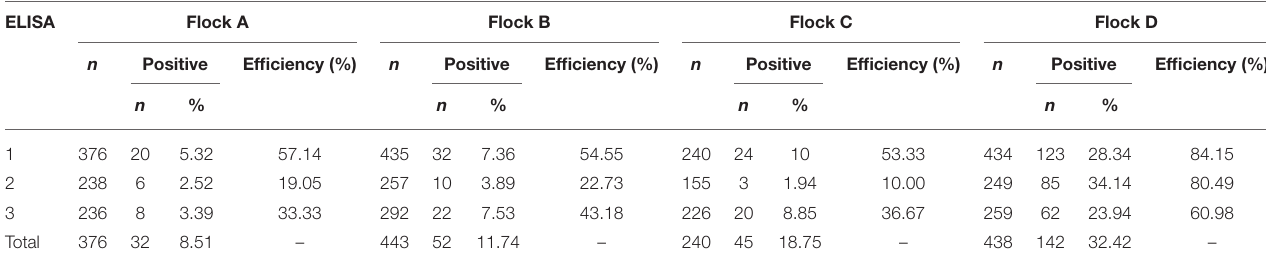
TABLE 2 | SRLV serological analysis of sheep belonging to meat (A and B) or dairy (C and D) flocks, employing three commercial ELISAs (1, 2, and